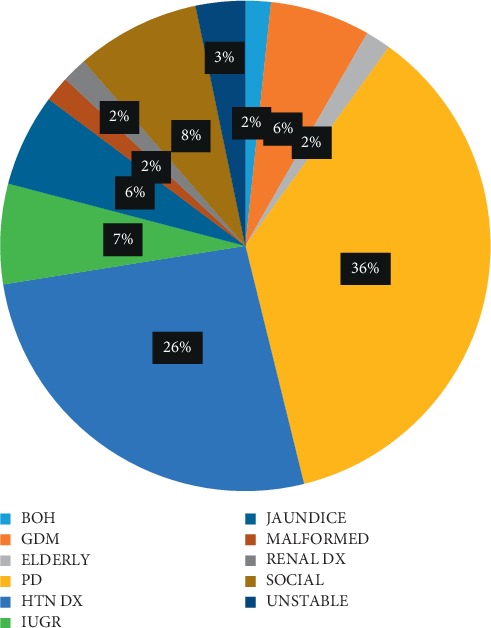
Indication for induction of labour. Key : BOH, bad obstetric history; GDM, gestational diabetes mellitus; ELDERLY, elderly primigravida; HTN DX, hypertensive disease in pregnancy; IUGR, intrauterine growth restriction; JAUNDICE, jaundice in pregnancy; MALFORMED, congenital malformation; PD, postdated pregnancy; RENAL DX, renal disease; SOCIAL, social induction of labour; UNSTABLE, unstable lie.